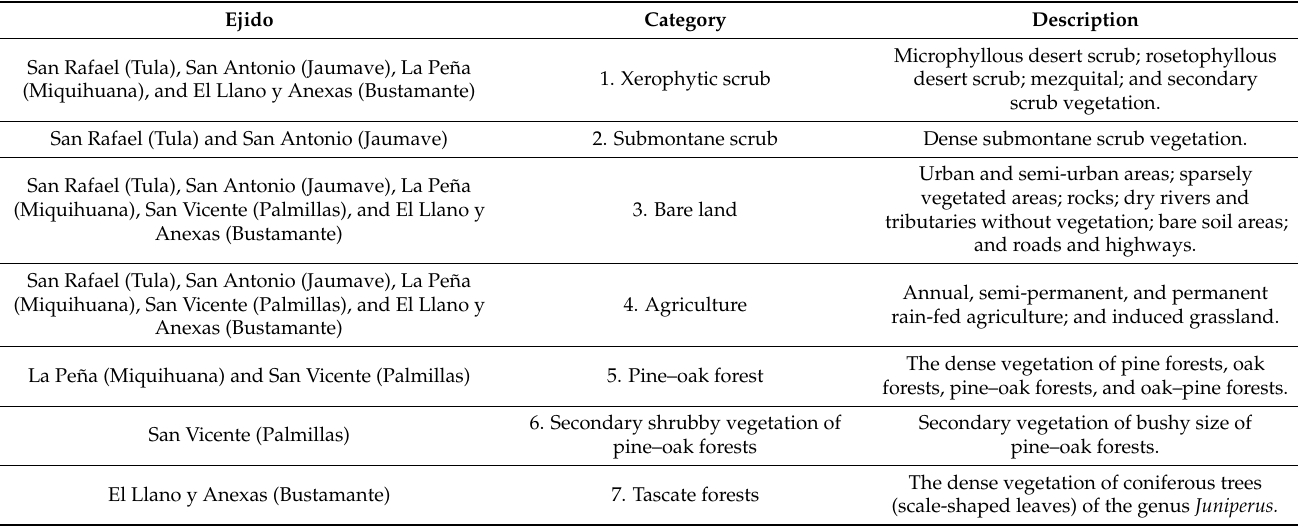
Table 2. Land use/land cover categories (LULC) in the Tamaulipan Highlands, Tamaulipas, Mexico. Ejido